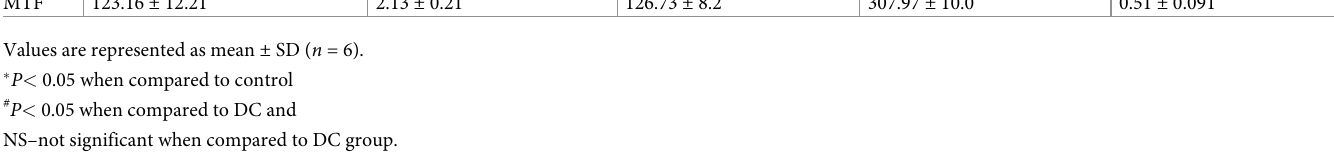
enhanced by 49%, 39%, 49%, and 50% in the groups treated with Myr, HP, Myr+HP, and MTF, respectively (P < 0.05, when compared with DC). In the same manner, GT activity was significantly (P < 0.05) enhanced in the liver by 49%, 44%, 26%, and 45% in the groups fed with Myr, HP, Myr+HP, and MTF, respectively, compared to DC rats. liver, and the level of protein carbonyls was estimated in the liver and plasma ( Table 5 ). A